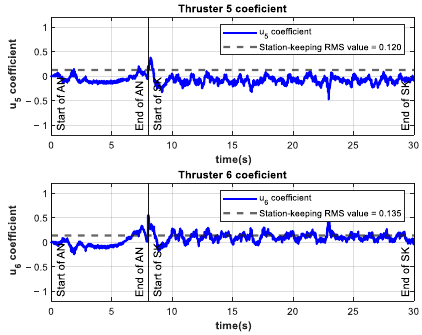
Figure 11. Experimental results of the control test for depth station-keeping. Control signal 𝜏 𝑧 ( left ) and thruster coefficients 𝑢 5 , 𝑢 6 ( right ). No external disturbances were introduced.